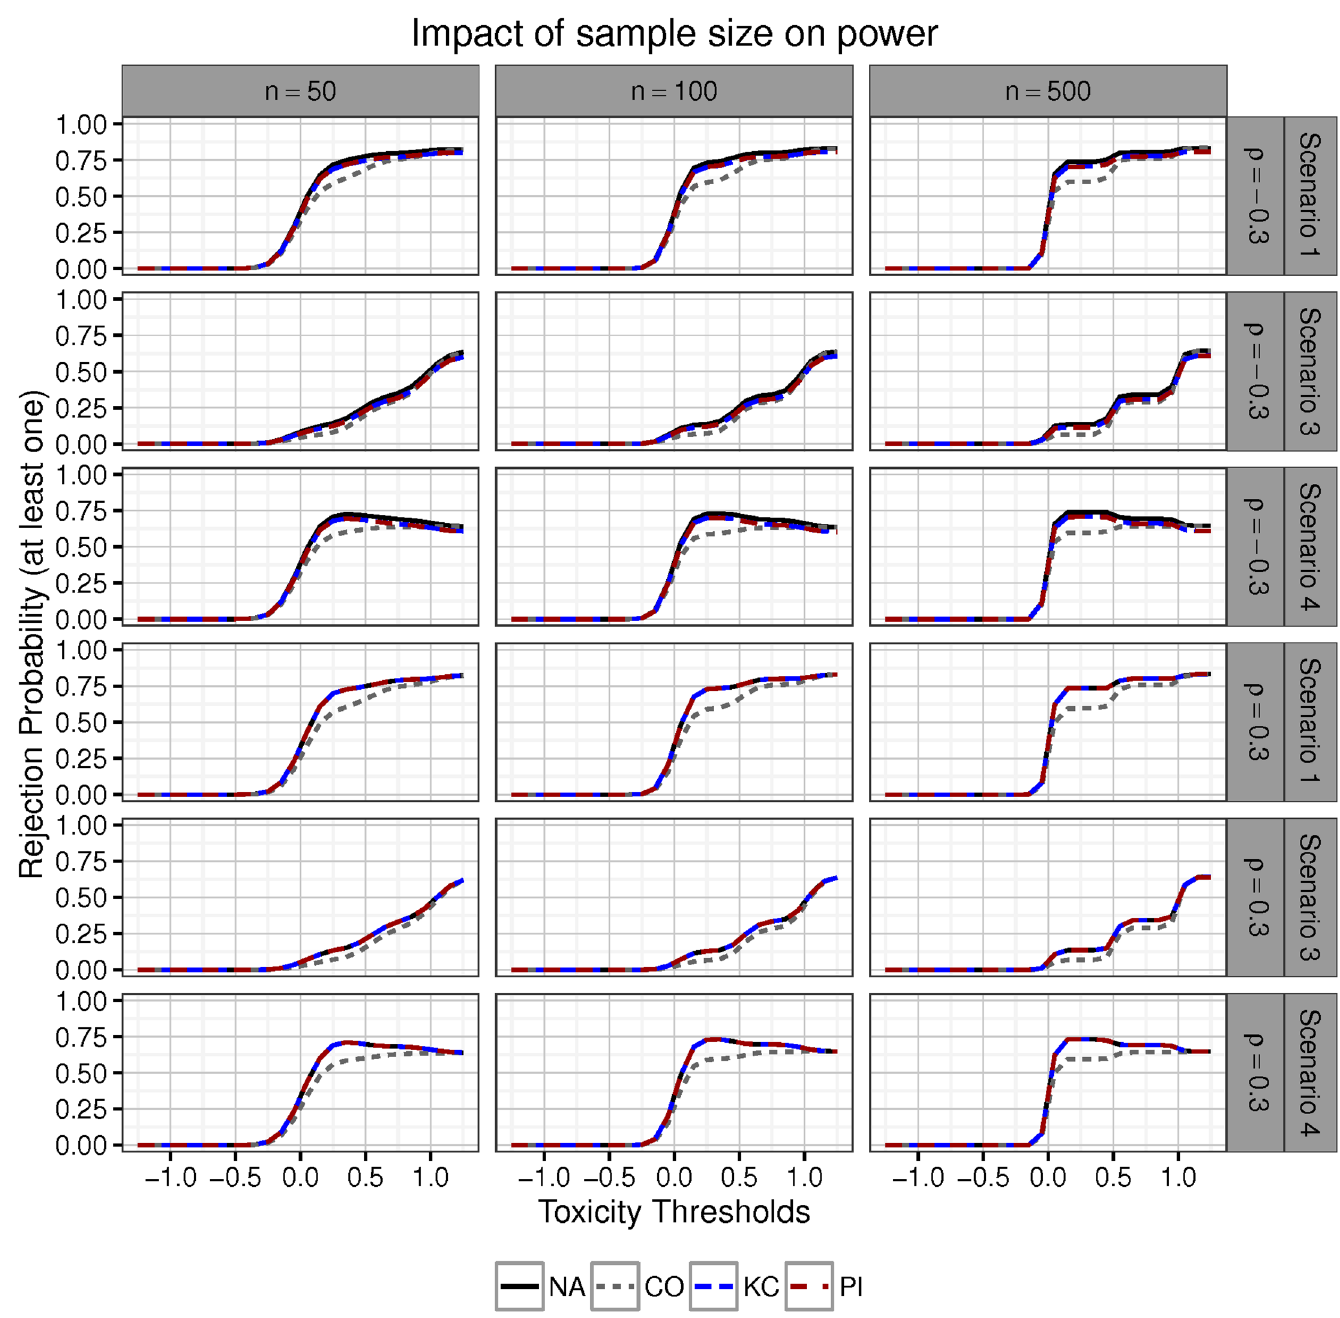
Fig 5. Power of the four two-step procedures under varying toxicity thresholds and (per-group) sample sizes in Scenarios 1, 3, and 4. For each group size, the effect size μ 3 is chosen as the difference a single treatment comparisoncan detect with power 0.9. The correlation is set as ρ 2 { − 0.3, 0.3}.